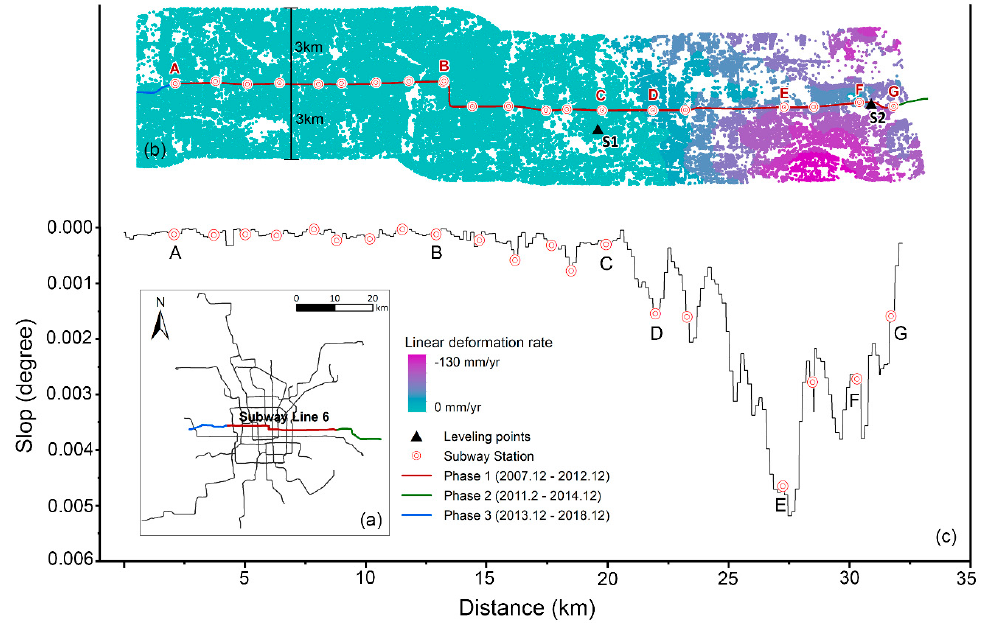
Figure 6. ( a ) Distribution map of Beijing subway network and location distribution of subway line 6 (L6). ( b ) Deformation rate of 3 km bu ff er zone along L6. S1, S2 are leveling points. ( c ) Profile of the deformation rate gradient of L6-I. Subfigures b and c correspond to each other. (A) Haidianwuluju Station, (B) Nanluoguxiang Station, (C) Jintailu Station, (D) Shilibao Station, (E) Fangqiao Station, (F) Changying Station, (G) Caofang Station. S1 and S2 are two leveling monitoring points close to L6.